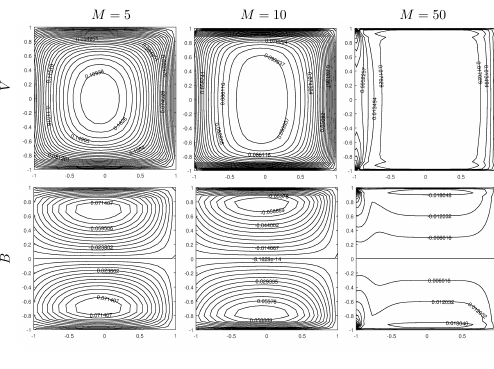
Figure 5. Velocity and induced magnetic field from direct problem, π , α = 0 . 2 , c = 0 . 3. β = 2